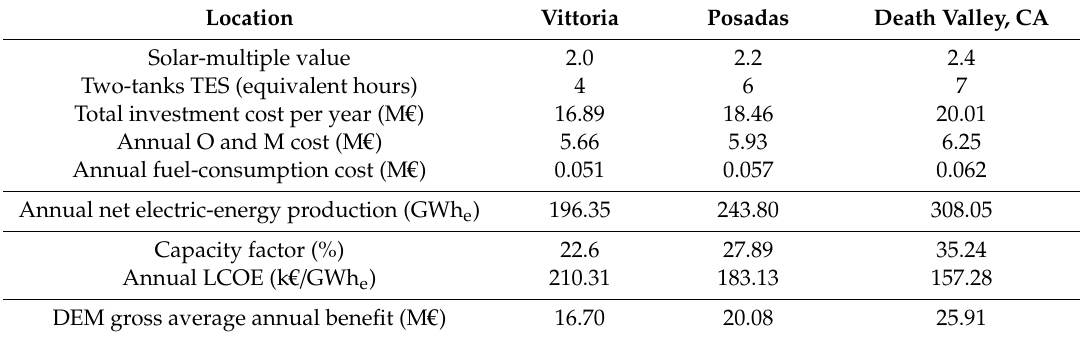
Table 9. Optimal economic results in a DEM for a 100 MW e PT power plant with two-tank molten-salt